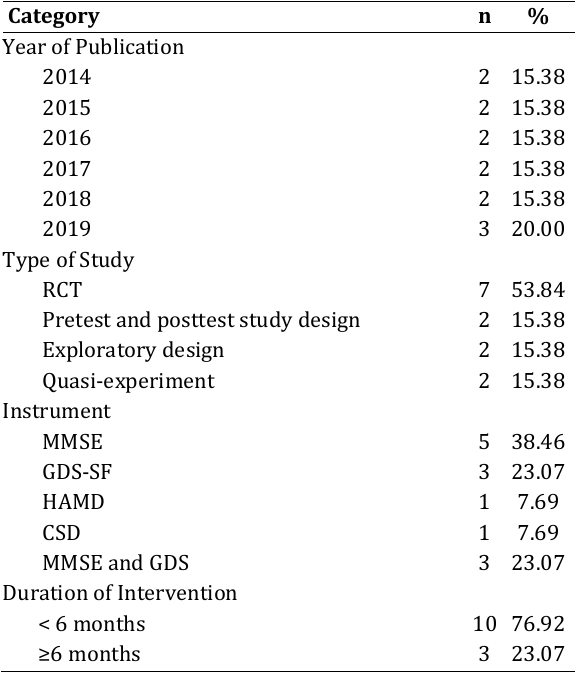
Table 1. General Characteristics of Selected